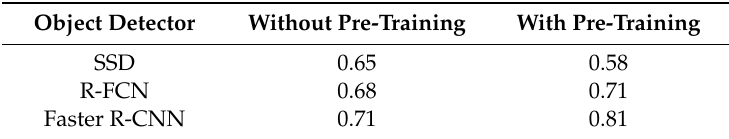
Table 4. Comparison of di ff erent object detectors on the conifer seedling dataset. The evaluation used MAP@0.5IoU as